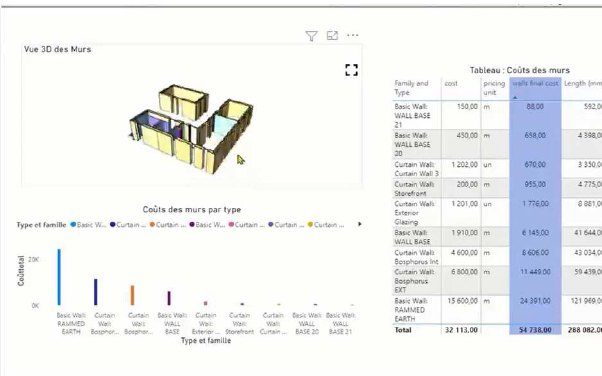
Figure 7. Cost Dashboard example